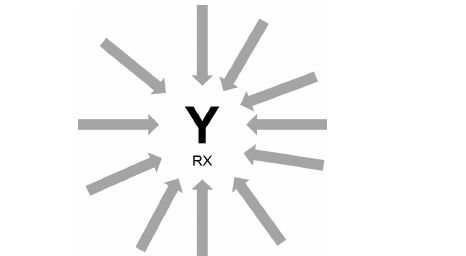
Figure 3. Illustration for the physical interpretation of Rayleigh fading: no dominant path exists and many scattered components (arrows) with roughly the same power level (similar length to the arrows) are superimposed.